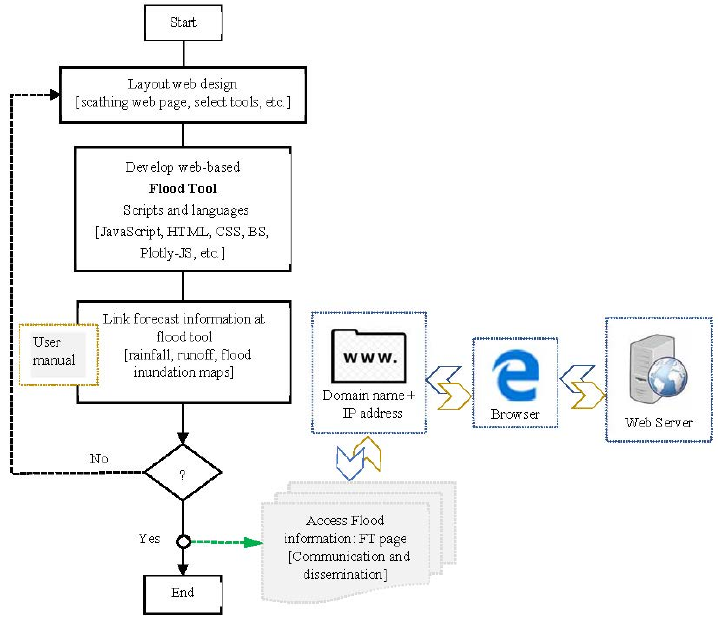
Figure 4. Schema of developing the flood tool and its purpose.